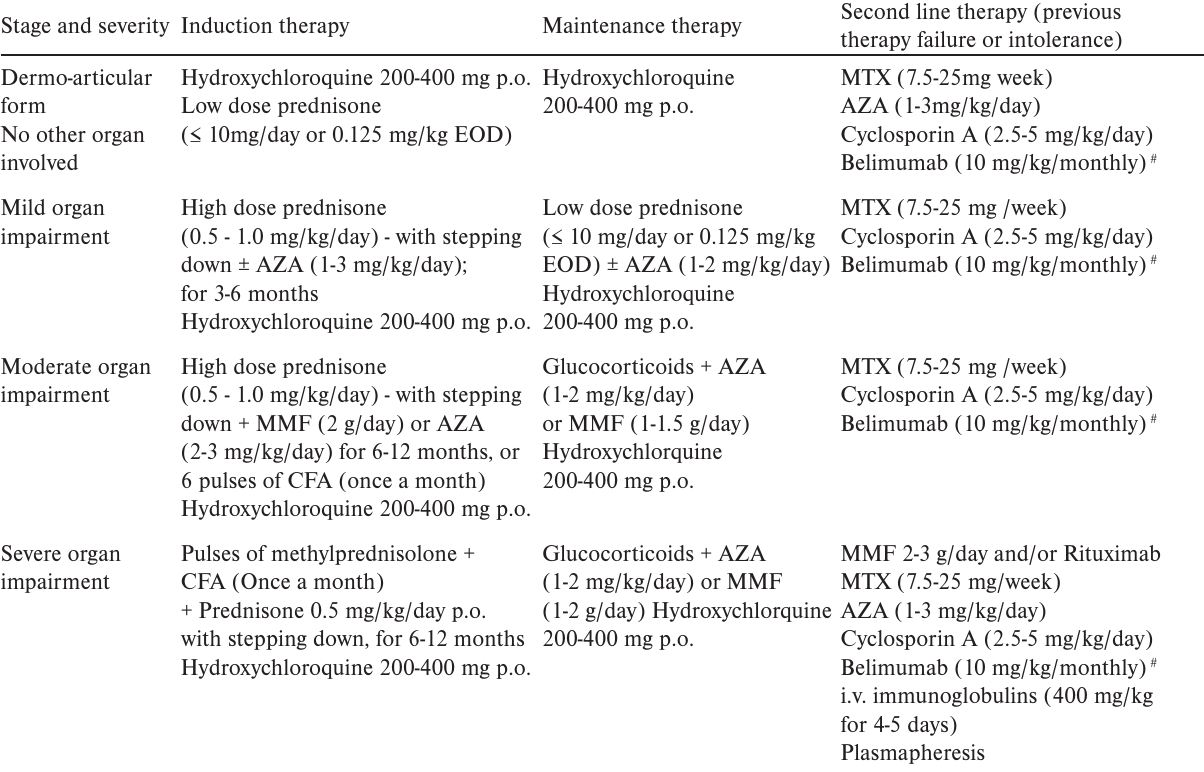
Table 2. SLE therapy options, according to stage and severity 19-21